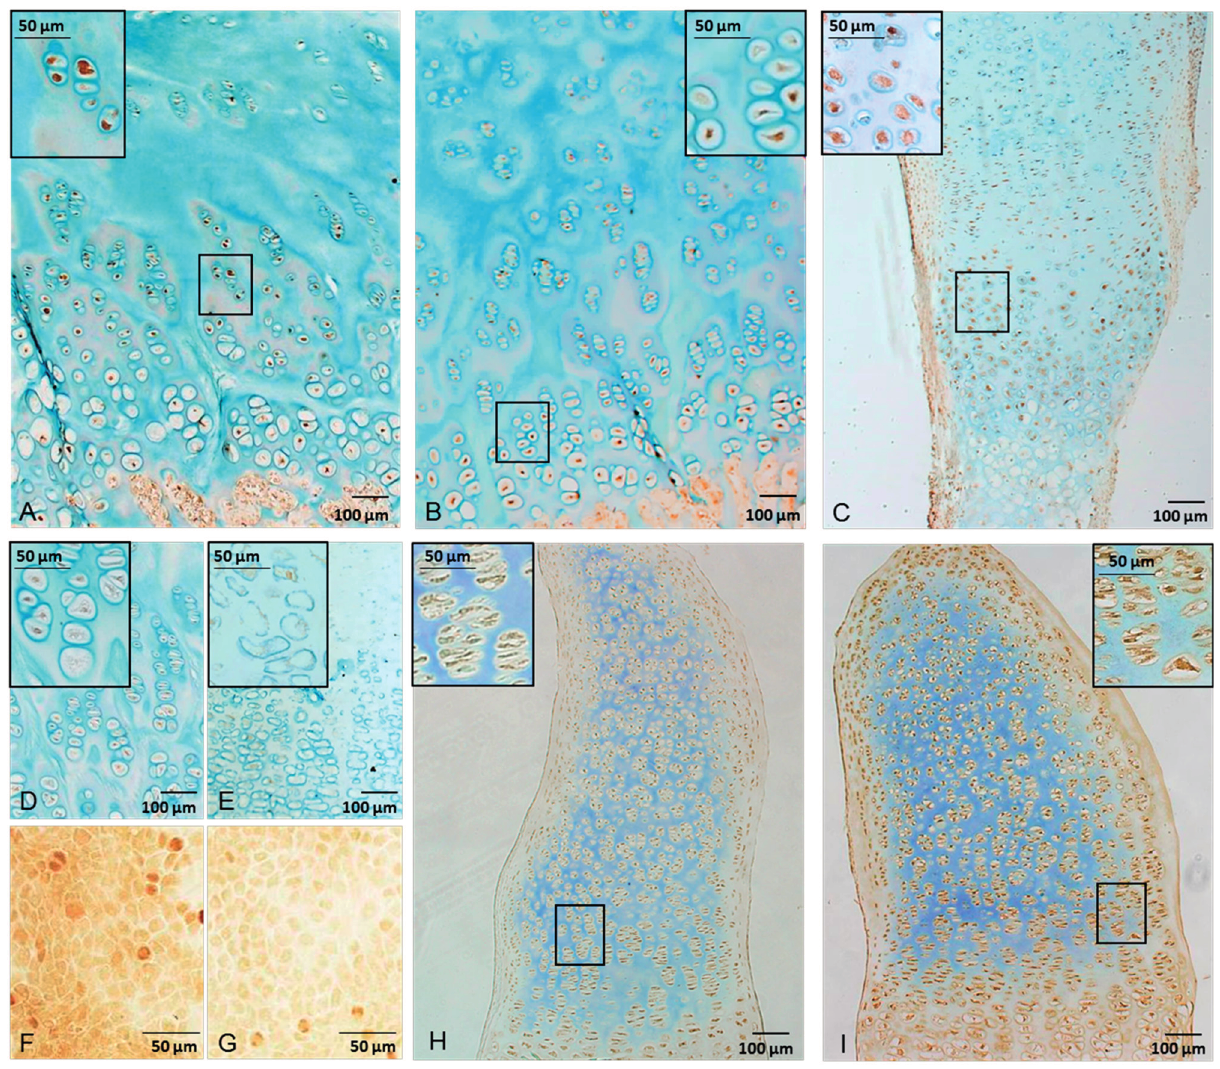
Figure 1. Immunohistochemistry pictures of AhR protein expression in human growth plate tissues from one boy in late puberty, Tanner Stage G5 ( A ), and one girl in early puberty, Tanner Stage B1 ( B ). Chondrocyte expression of the AhR was also confirmed in the fetal rat metatarsal bones used in the culture experiments ( C ). As negative controls for human growth plate ( D ) and rat metatarsal ( E ), tissue was incubated with unspecific IgG instead of primary antibody. The specificity of the AhR (H-211) rabbit polyclonal antibody was validated in HaCaT keratinocytes transfected with either an empty vector expressing the AhR ( F ) or a knockdown vector to express a minimum amount of the protein ( G ). Expression of CYP1A1 in metatarsals after 19 days in culture with either vehicle ( H ) or 10 nM TCDD ( I